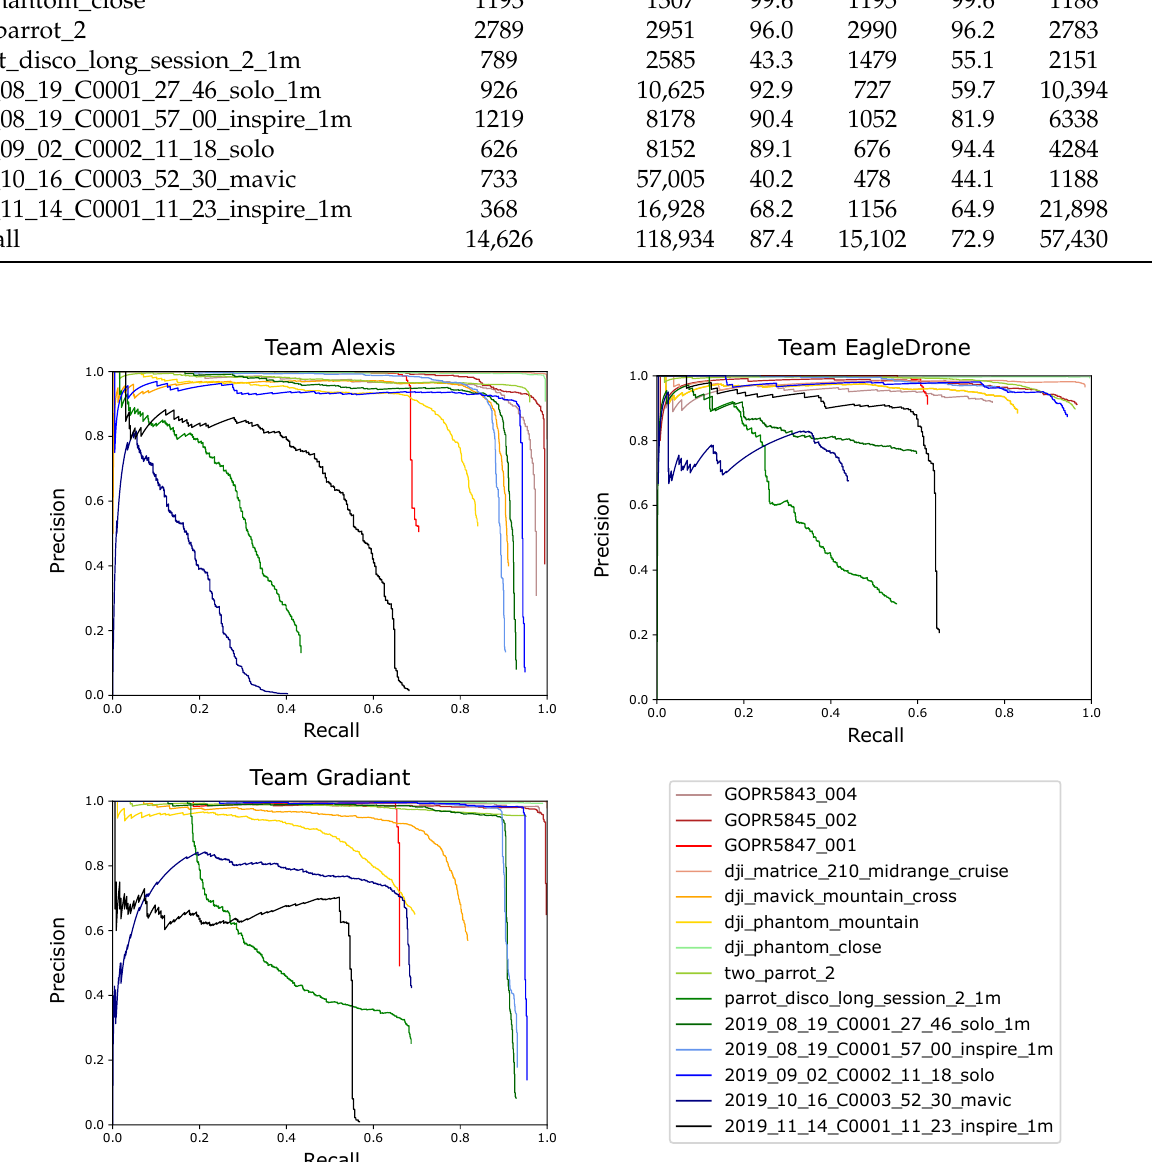
Figure 22. Comparison of the detection results in terms of precision-recall curves. Figures 23 and 24 show qualitative detection results of each teams’ best submission. All methods achieve good detection results for different drone types and a large range of